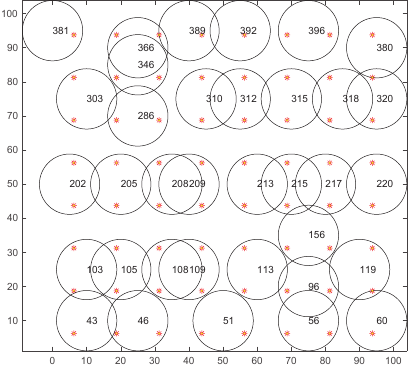
Figure 7. The coverage diagram after the 15th iteration.